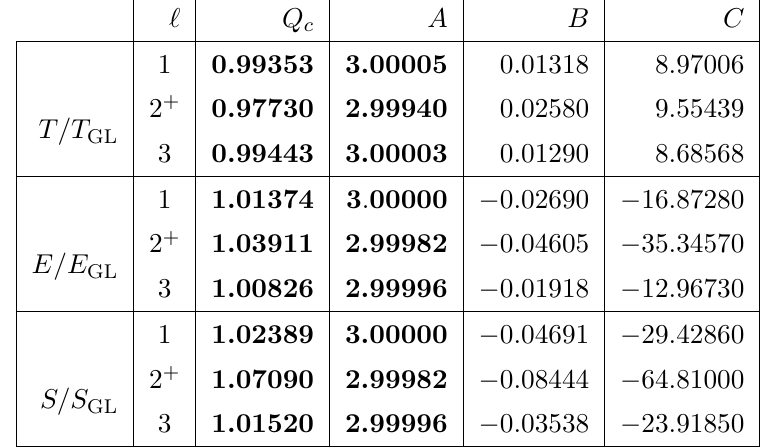
Table 4. Critical exponents and other parameters obtained from the fits of the temperature, energy and entropy of the different lumpy solutions in AdS 7 . Note that for a given ‘ , the critical 4 × S exponents for the energy and the entropy are exactly the same. This is not surprising, since they are not independent: recall that in D = 11 the energy is found by integrating the 1st law of black hole